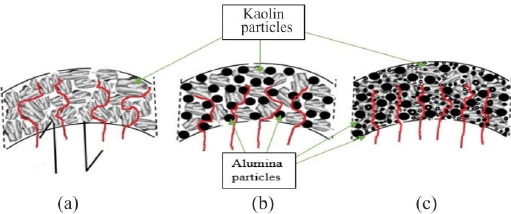
Fig. 5 Schematic presentation of the paths for solvent and nonsolvent during phase inversion process: (a) kaolin; (b) kaolin–alumina-1; (c)